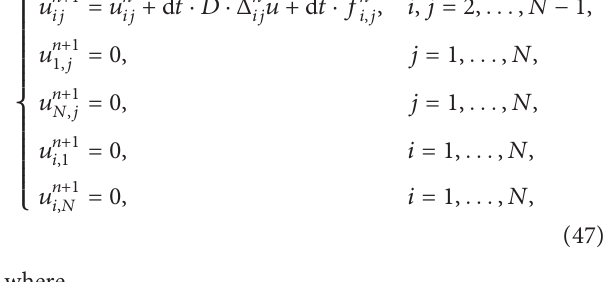
� 100. (c) The error for N r